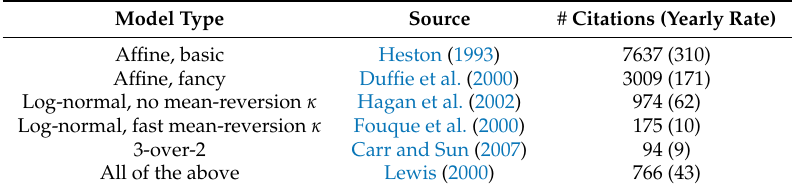
Table 1. Impact of stochastic volatility research measured by citations in Google Scholar on 15 February